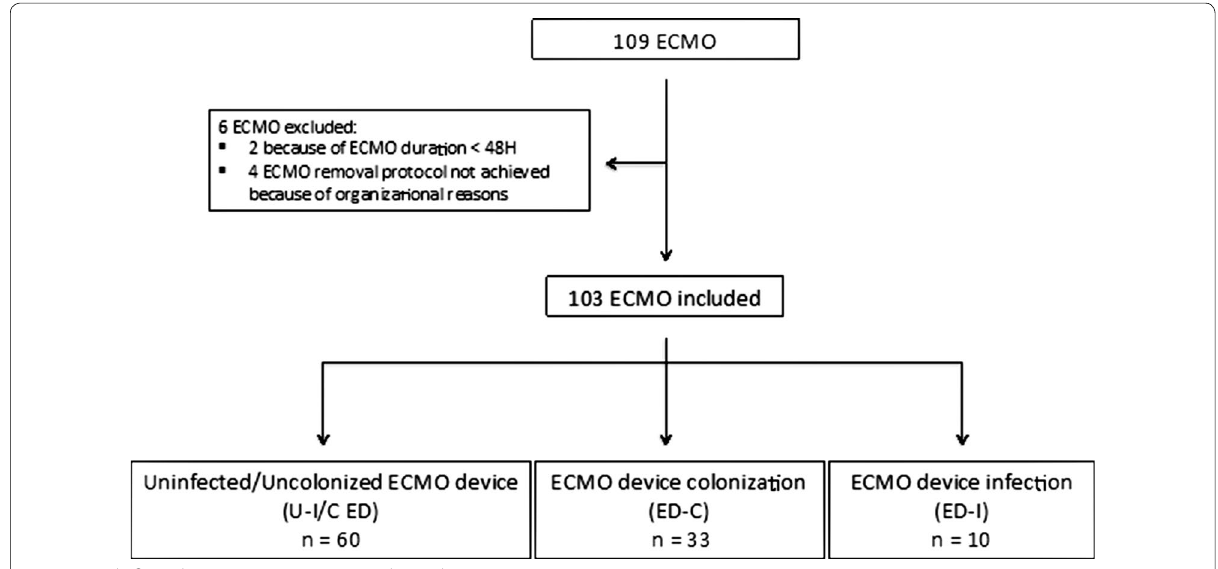
Fig. 1 Study flow chart. ECMO, extracorporeal membrane